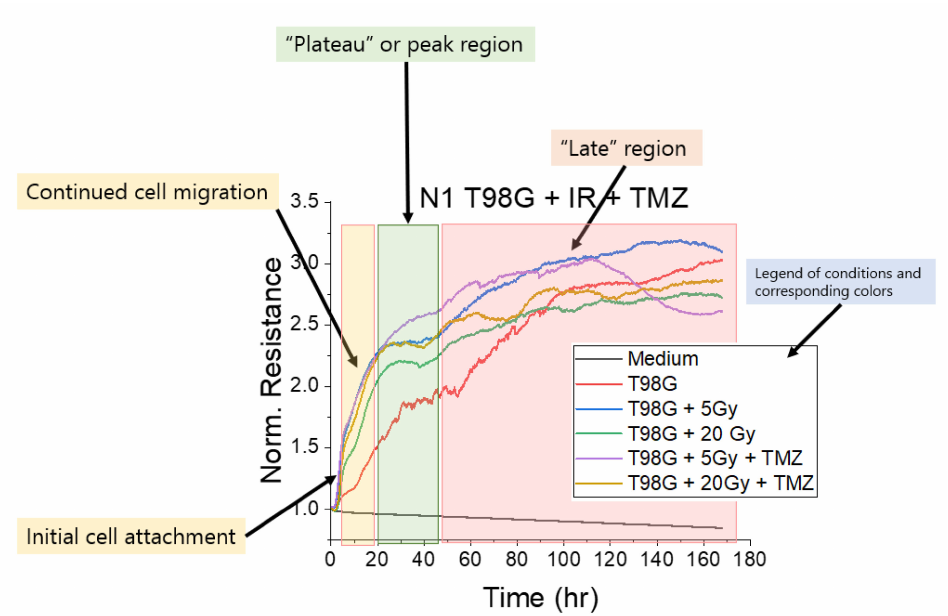
Figure 1. Typical ECIS plot of normalized resistance (64,000 Hz). Cells begin by adhering to the bottom surface of the array, forming an initial buildup region. After initial attachment to the substrate, cells migrate toward the preferred distribution. For T98G, cells migrated to cover the available space in the array, increasing resistance until reaching a peak, dubbed the “plateau region,” at which time cells have reached maximal coverage. The late region is characterized by continued proliferation and/or cell death, which increases or decreases resistance,